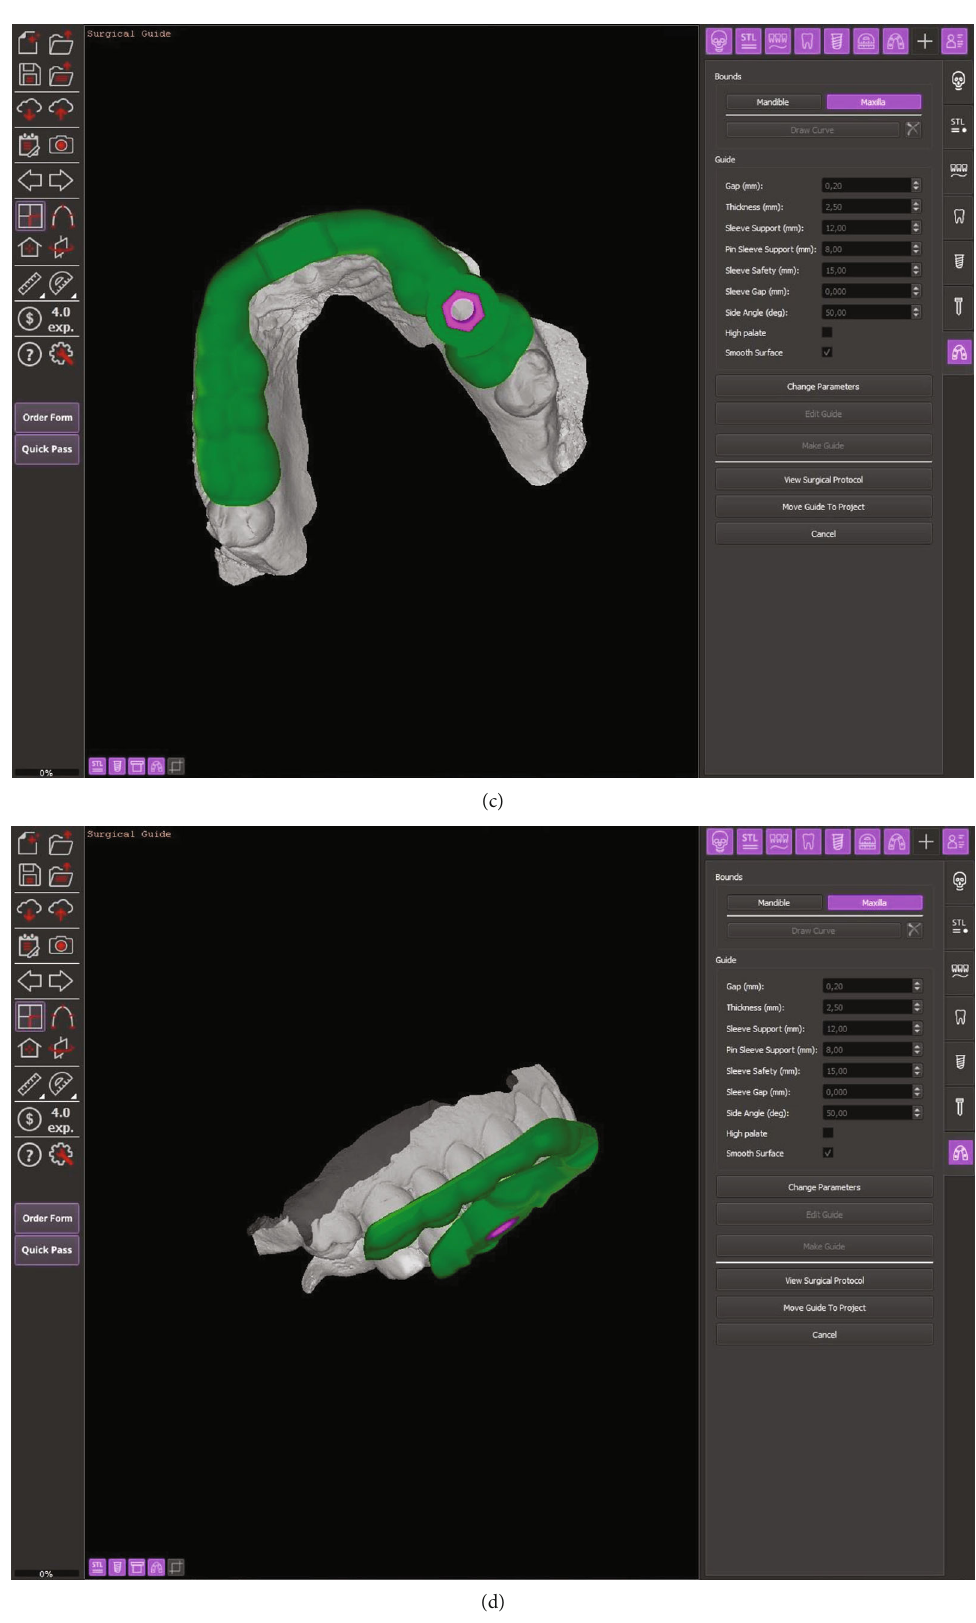
Figure 3: (a) Software evaluation and digital planning of the surgical procedure. (b – d) Digital modeling of the surgical